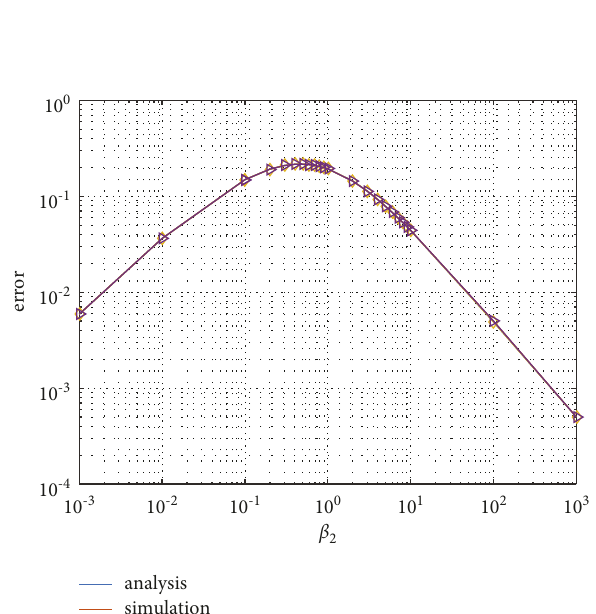
Figure 2: Instantaneous error versus β